Question: What kind of plot is shown here?
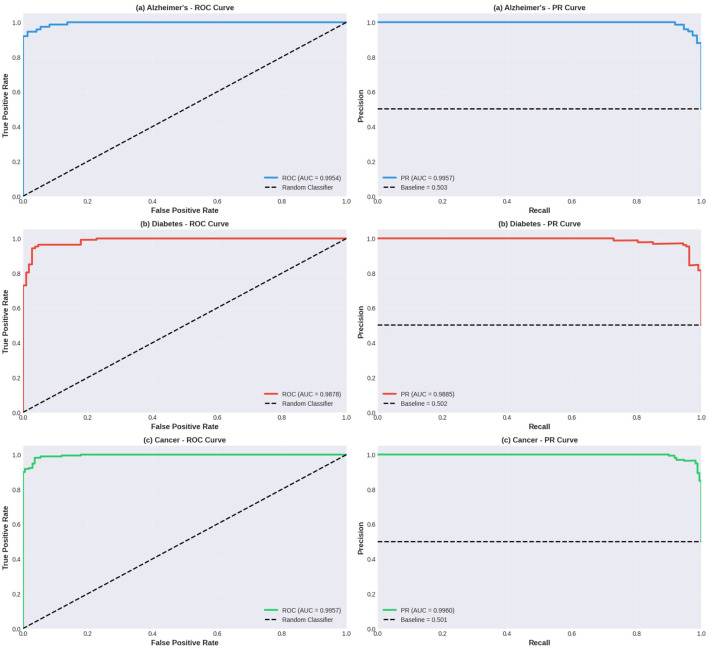
Answer: line